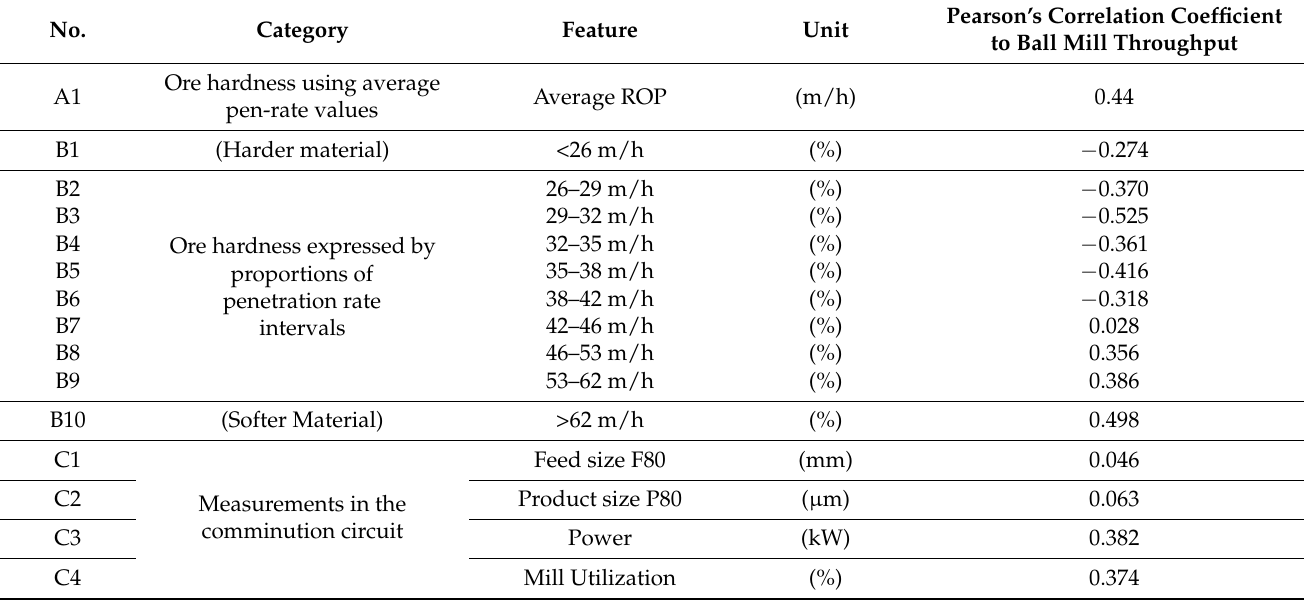
Table 2. Pearson’s correlation coefficient between predictor variables (geological, comminution-related) and ball mill